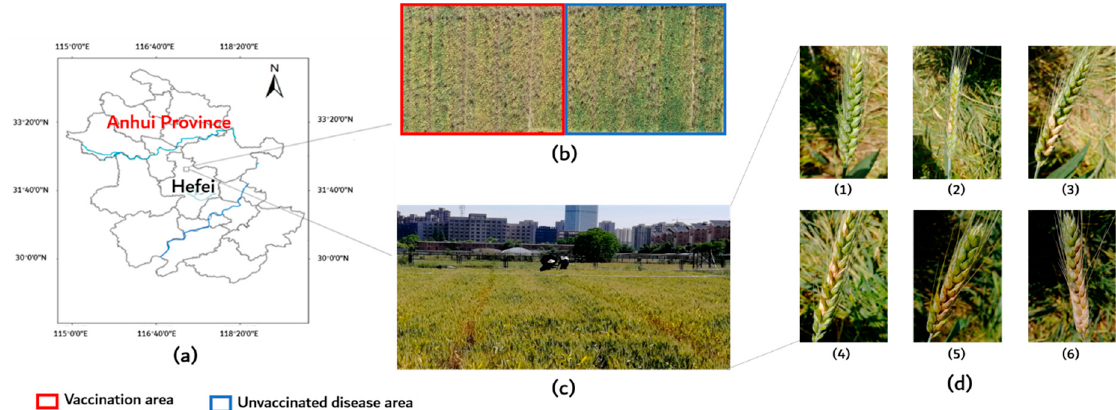
Figure 1. Experimental field and wheat Fusarium head blight image collection. ( a ) Experimental site; ( b ) Vaccination and unvaccinated experimental area; ( c ) fieldwork situation; ( d ) individual healthy/infected wheat ear; (1) healthy wheat ear with a disease grade of 0; (2) wheat ear with a disease grade of 1, (3) 2, (4) 3, (5) 4, and (6) 5.